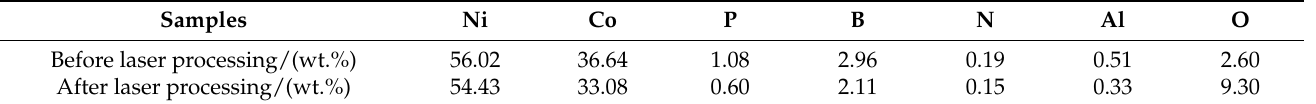
Figure 15. Elemental mapping images of sample textured surface. Table 5. The chemical composition of samples before and after laser treatment.